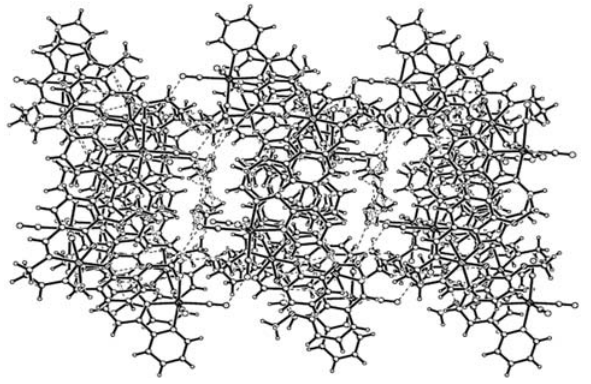
Figure 3. The cell packing diagram along b for complex 1